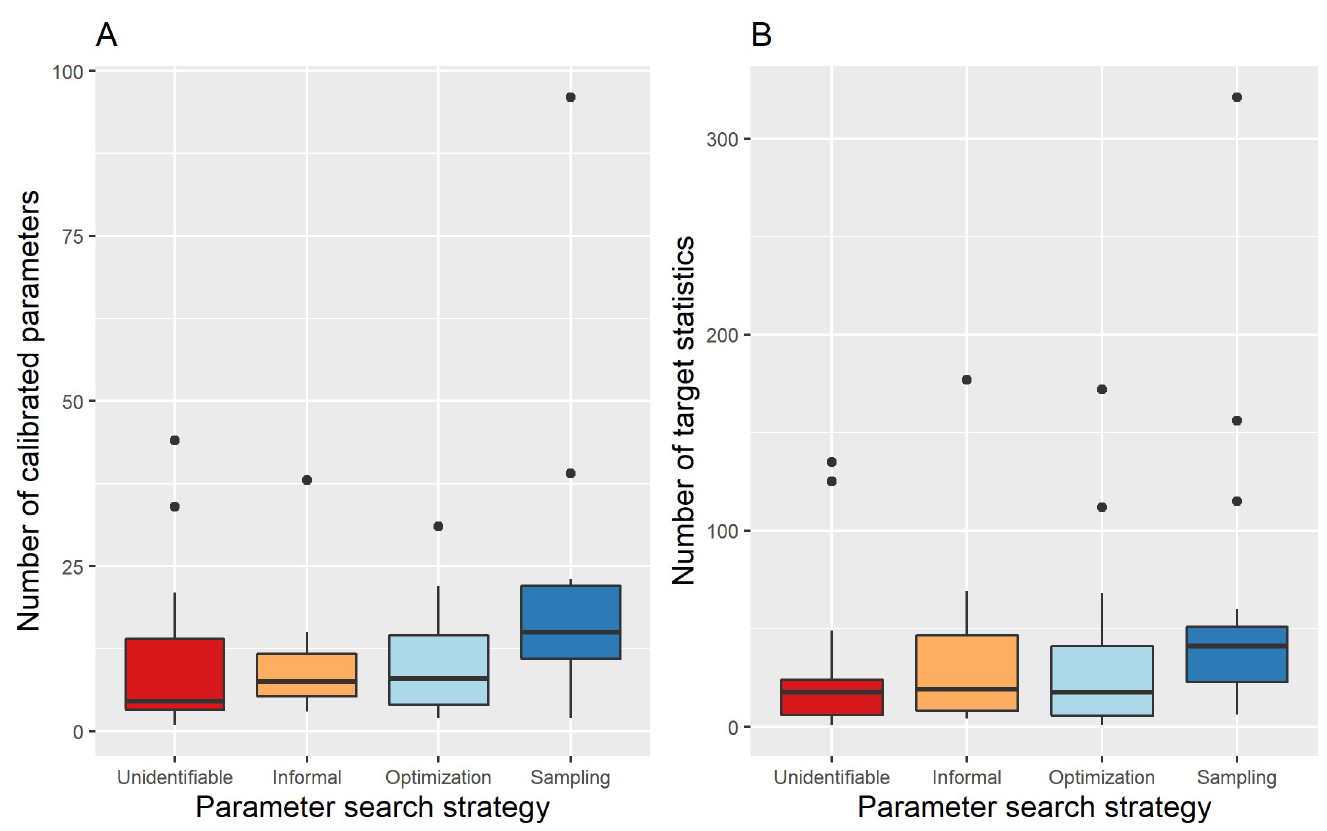
Fig 3. Comparison of the number of calibrated parameters and target statistics between different parameter search strategies. (A) Boxplots of the number of calibrated parameters for different parameter search strategies. (B) Boxplots of the number of target statistics for different parameter search strategies.